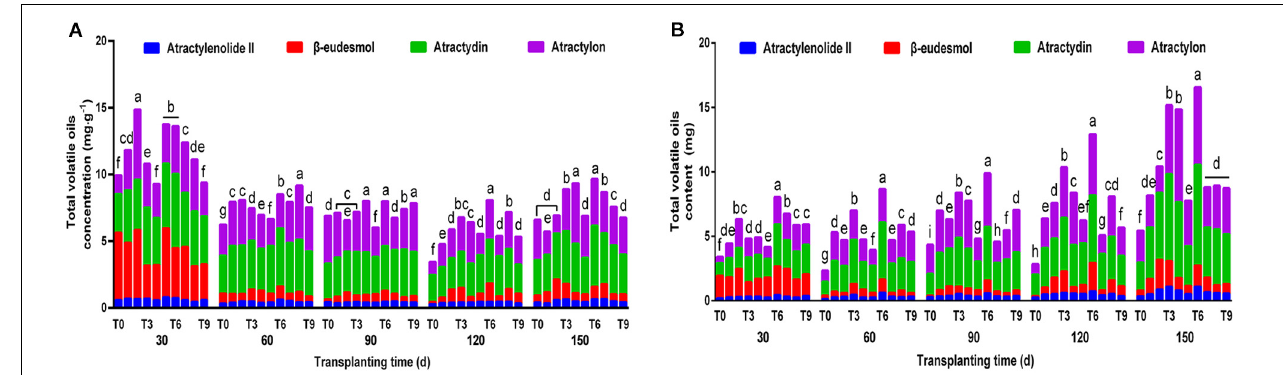
FIGURE 3 | The effects of NPK combined application on total volatile oil concentration (A) and content (B) of A. chinensis ( n = 3). Note: (a) The total concentration and content of volatile oil in A. chinensis seedlings were 7.2768 ± 0.1528 mg · g − 1 and 1.8338 ± 0.0385 mg, respectively. (b) Different lowercase letters indicate that the effects of different NPK combinations on A. chinensis were significantly different in the same period ( p < 0.05). (c) The composition of fertilization treatments: T0, N 0 P 0 K 0 ; T1, N 1 P 1 K 1 ; T2, N 1 P 2 K 2 ; T3, N 1 P 3 K 3 ; T4, N 2 P 1 K 2 ; T5, N 2 P 2 K 3 ; T6, N 2 P 3 K 1 ; T7, N 3 P 1 K 3 ; T8, N 3 P 2 K 1 ; and T9, N 3 P 3 K 2